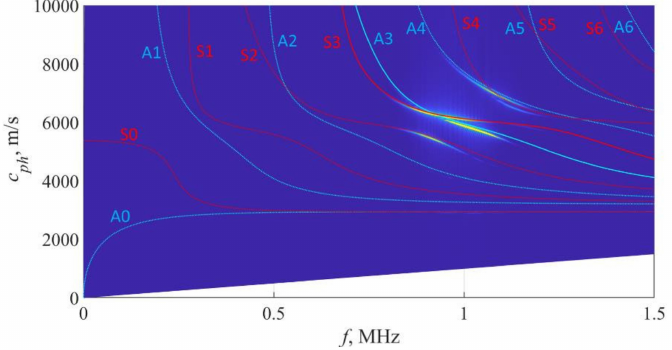
Figure 18. Reconstructed phase velocity dispersion curves from FE results on 10 mm plate.